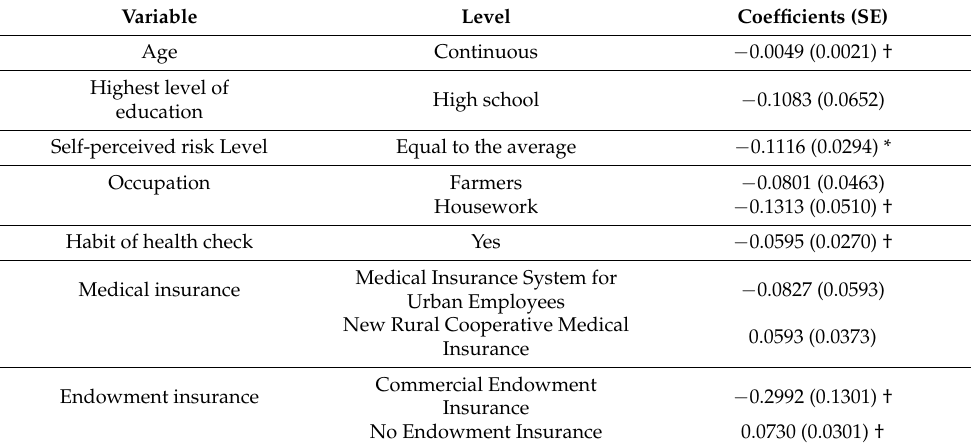
less likely to opt out from a screening programme. Table 5. Predicting opt-out